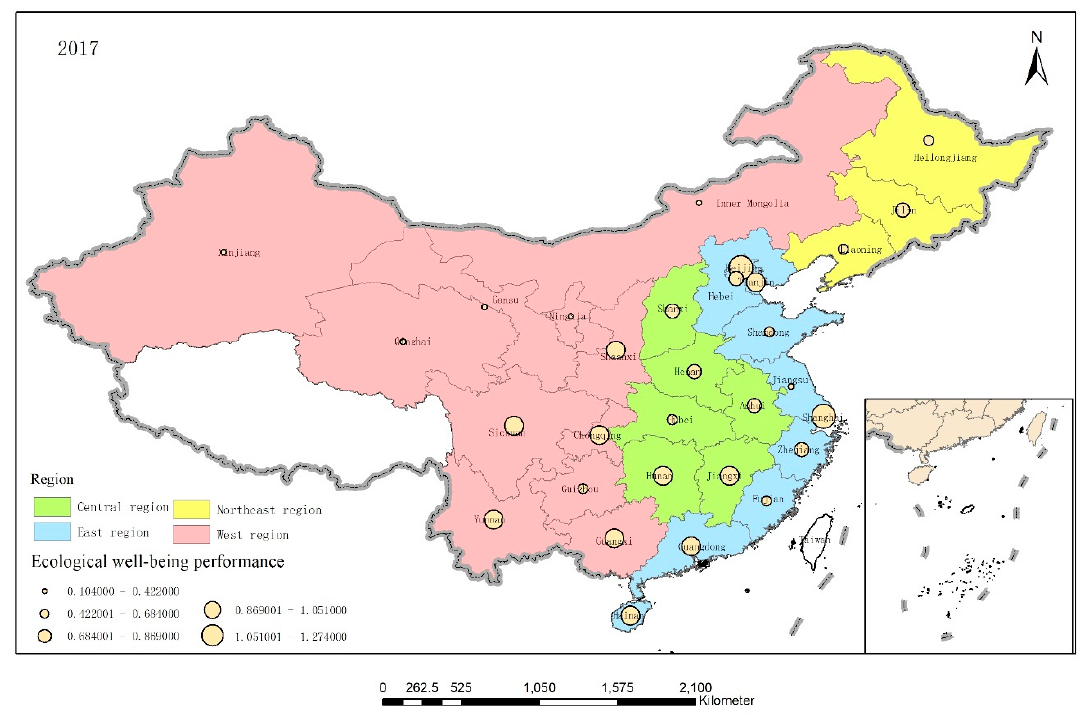
Figure 7. The EWP distributions in the 30 provinces in 2017.